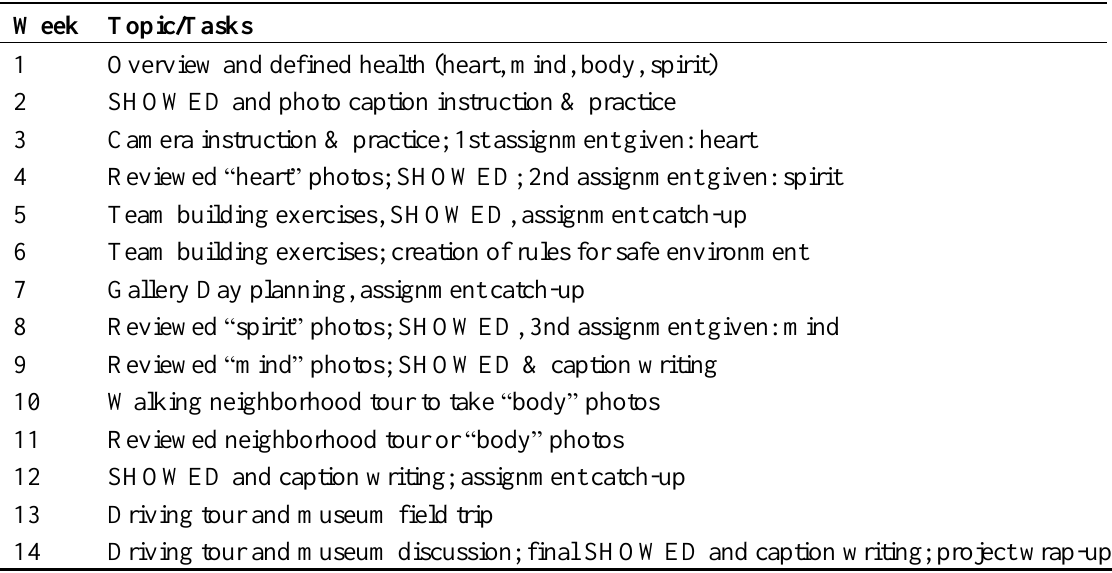
Table 2. Weekly PhotoVoice program